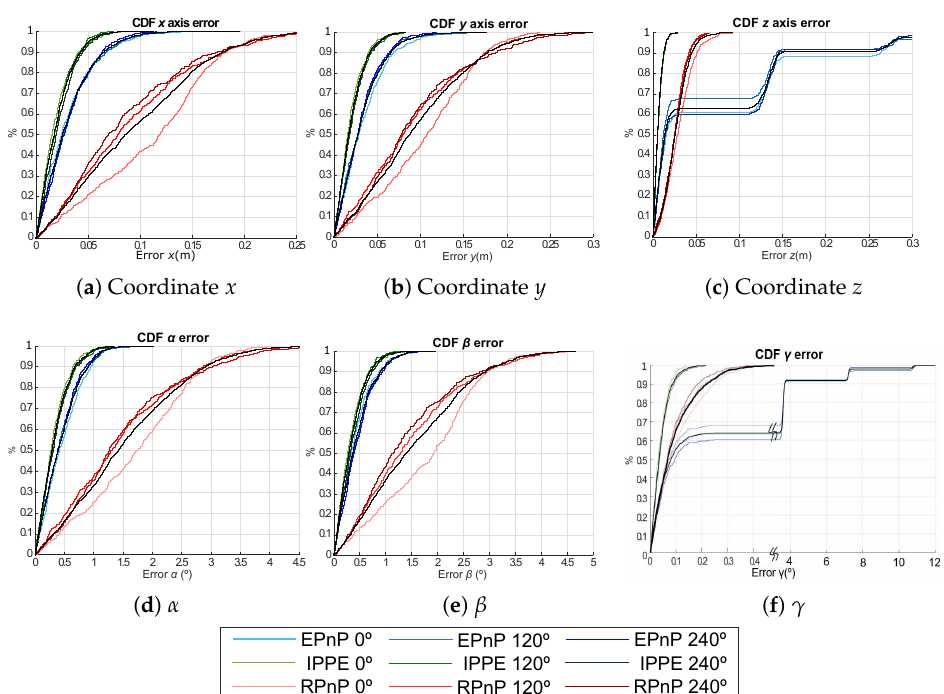
Figure 6. CDF of the absolute pose errors for EPnP, IPPE and RPnP according to the rotation in the Z axis γ = {0 ◦ , 120 ◦ , 240 ◦ }.